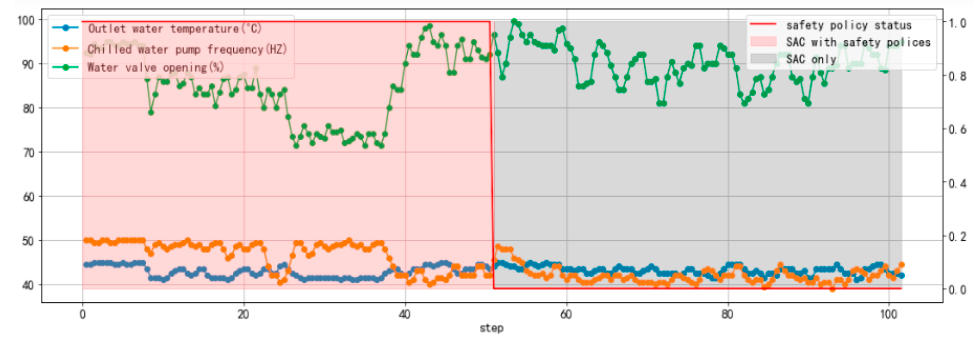
Figure 12. AB test action trends by safety policies.